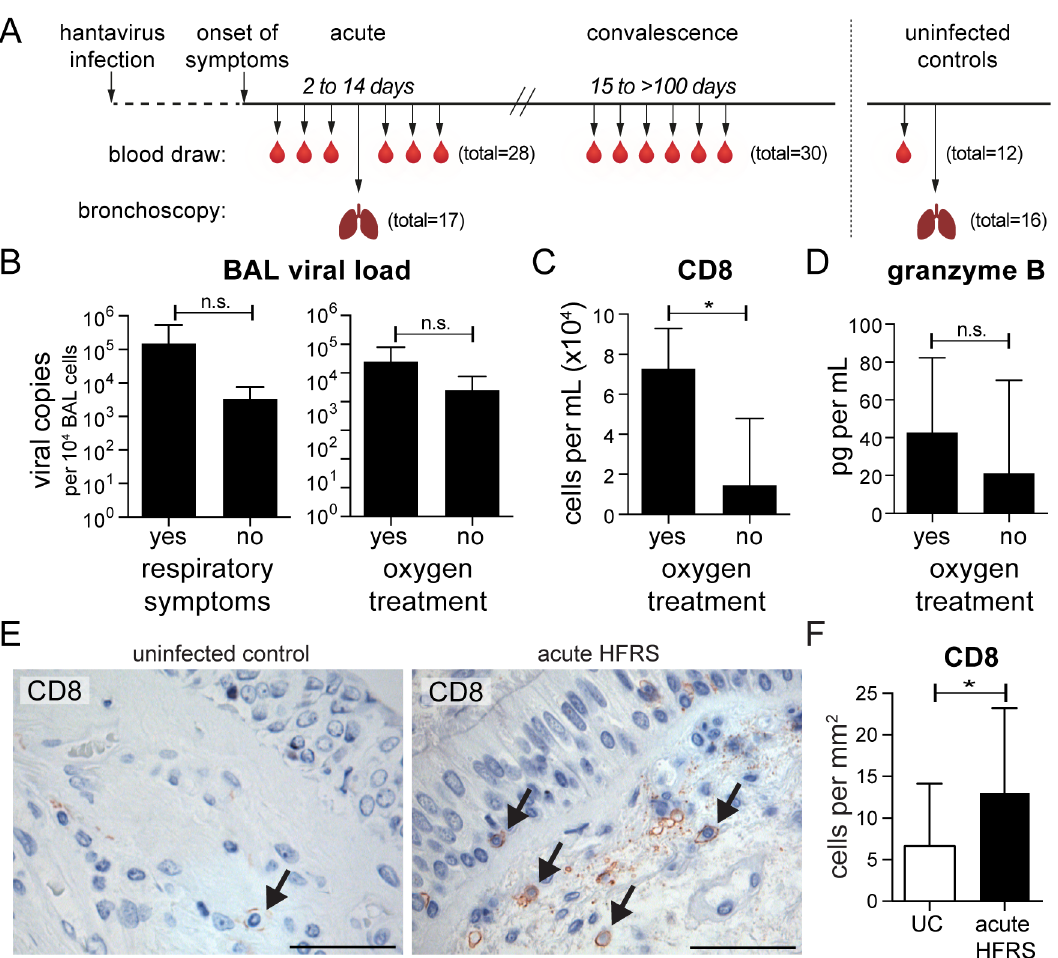
Fig 1. Respiratory involvement in hantavirus-infected patients. (A) Hantavirus-infected patients diagnosed with hemorrhagicfever with renal syndrome (HFRS patients) underwent bronchoscopy (medianday 9, n = 17) for collectionof endobronchial biopsiesand bronchoalveolar lavage(BAL). Multiple blood draws were taken from 12 patients duringacute (median day 6, total of all patients = 28) and convalescent (median day 89, total of all patients = 30) phases. Uninfected controls (UC) were sampledfor blood(n = 12) and endobronchial biopsies(n = 16). (B) Detectableviral load in BAL cells of 15 patients were further classifiedaccordingto whetherthey experienced respiratory symptoms (left panel) or needed oxygen treatment (right panel). Bar graphs show mean ± SD. (C) Mean ± SDabsolute numbers of CD8 + T cells were evaluatedby flow cytometry in BAL of patients with or without oxygen treatment. (D) Granzyme B was measuredin BAL fluid of patients with (n = 5) or without (n = 12) oxygen treatment and presented as mean ± SD. (E) Representative images of CD8 staining in endobronchial biopsiesfrom UC (n = 16) and HFRS patient (n = 17). Specific stainingappearsin red, and cell nuclei are counterstained with hematoxylinin blue. Arrows indicate positive staining.Visualization was performed using immunohistochemistry. Scale bar, 50 μ m. (F) Bar graph summarizes mean ± SD comparing HFRS patients (n = 17) during the acute phaseof infectionwith UC (n = 16). The numberof CD8 + cells is expressedas cells/mm 2 . Statistical differences were assessedusing two-tailedMann–Whitney U-test: * p < 0.05,n.s. not